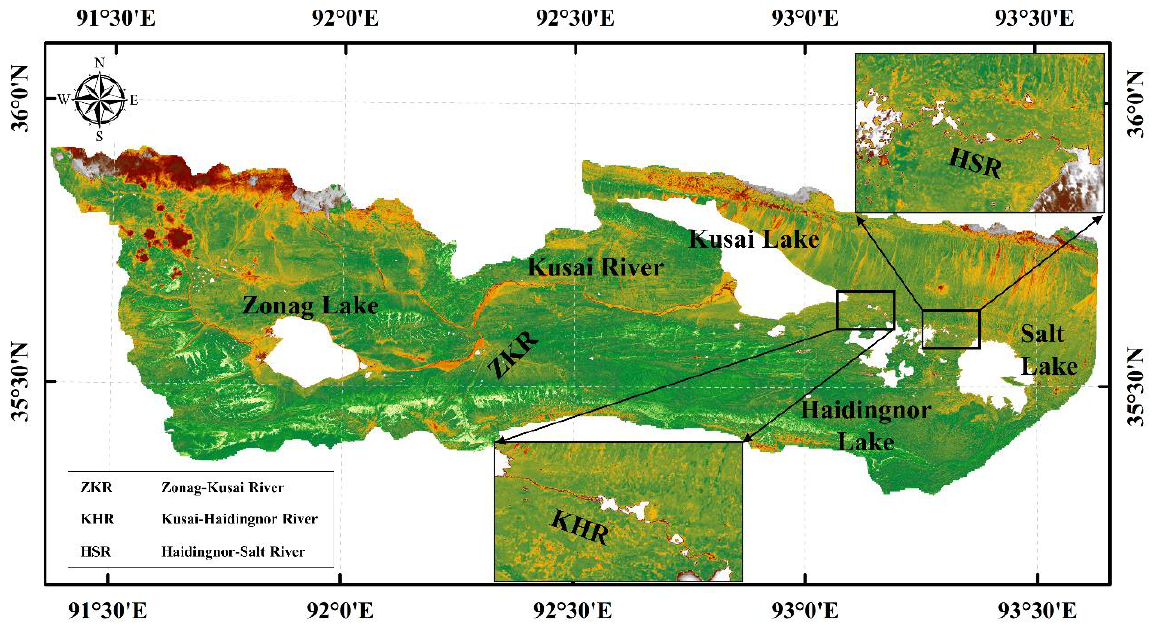
Figure 8. The EWI results of hydraulic connection in ZSLB (2013). From the EWI results during 2000 and 2020, the changes in water distribution between Kusai Lake and Haidingnor Lake, and between Haidingnor Lake and Salt Lake, were captured. In the 2000s, water distribution in the regions between Kusai Lake and Haidingnor Lake remained quite stable. However, since 2010, the area of Kusai Lake has expanded in the east, and some small lakes can be spotted on the map. By 2013, after KHR formed, the eastern side of Kusai Lake experienced a significant expansion compared to 2010. In the following years, KHR and the area of the eastern Kusai Lake and the western Haidingnor Lake remained relatively stable (Figure 9a). As for the region between Haidingnor Lake and Salt Lake, the expansion of water body can be observed from 2010 onwards, when several small lakes appeared between Haidingnor Lake and Salt Lake. After HSR was formed in late 2011 and remained stable in the following years, a significant expansion of the inlet channel of Salt Lake can be observed. The water area both in eastern Haidingnor and western Salt Lake had an obvious expansion, resulting in the distance between two lakes becoming closer than ever before in 2020 (Figure 9b).